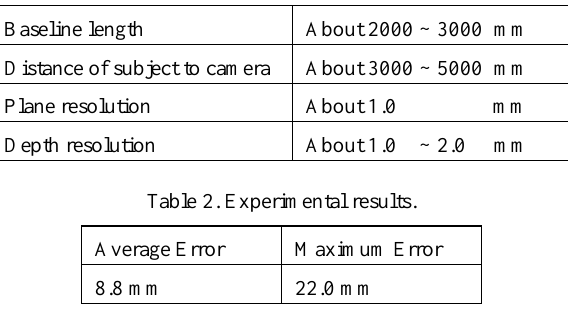
Table 1. The conditions of the experiment.